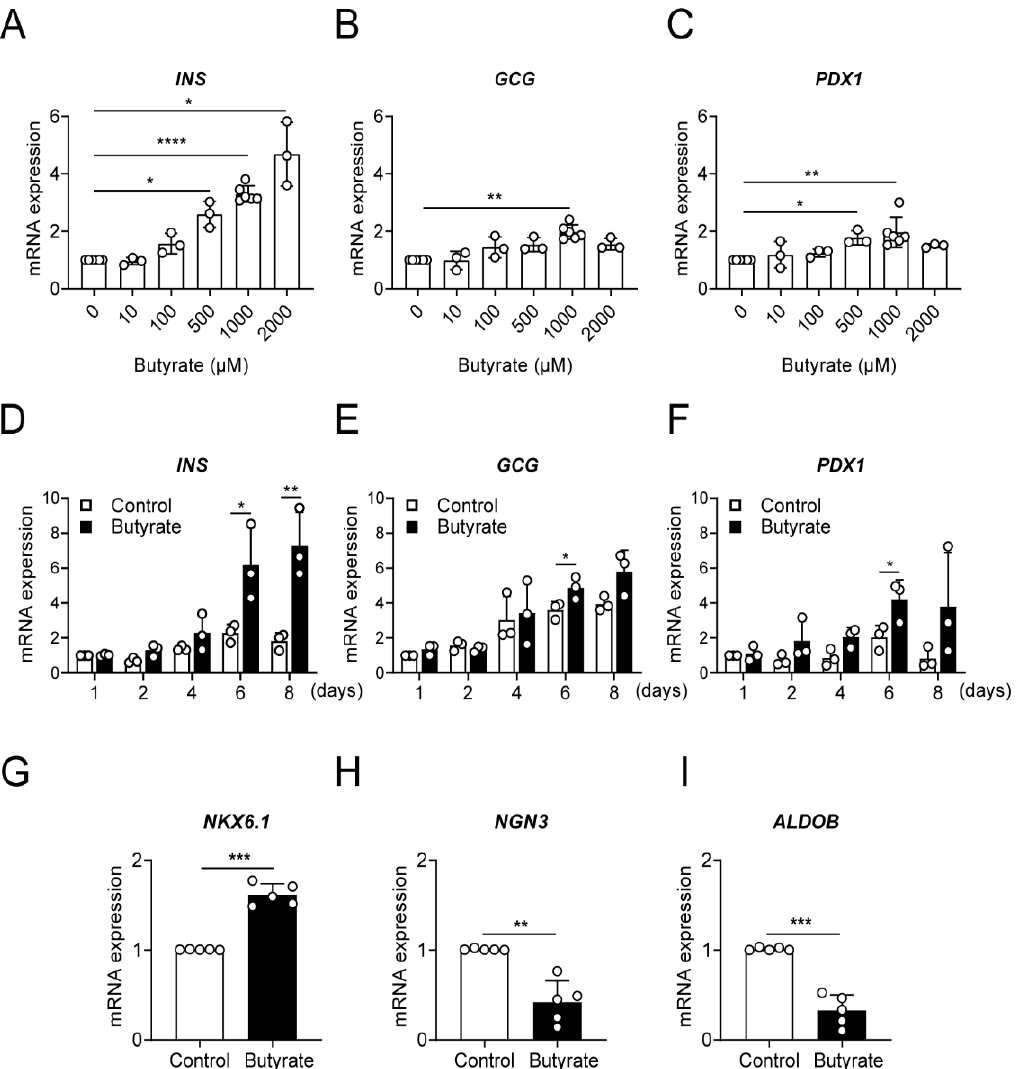
Figure 1. Exposure to butyrate significantly promotes beta cell maturation in a- and time-dependent manner. Relative gene expression of insulin ( INS ) ( A , D ), glucagon ( GCG ) ( B , E ), pancreatic and duodenal homeobox 1 ( PDX1 ) ( C , F ), NK6 homeobox 1 (NKX6.1 ) ( G ), neurogenin 3 ( NGN3 ) ( H ), and aldolase fructose-bisphosphate B ( ALDOB ) ( I ) assessed by RT-qPCR in NPICCs. ( A – C ) NPICCs were treated with 100–2000 µ M butyrate for six days, ( D – F ) 1000 µ M butyrate for one to eight days and ( G – I ) 1000 µ M butyrate for six days. Cells incubated without butyrate were used as controls. Data are presented as mean ± SD of three to six independent experiments. * p < 0.05, ** p < 0.01, *** p < 0.001 and **** p < 0.0001 vs. control groups.